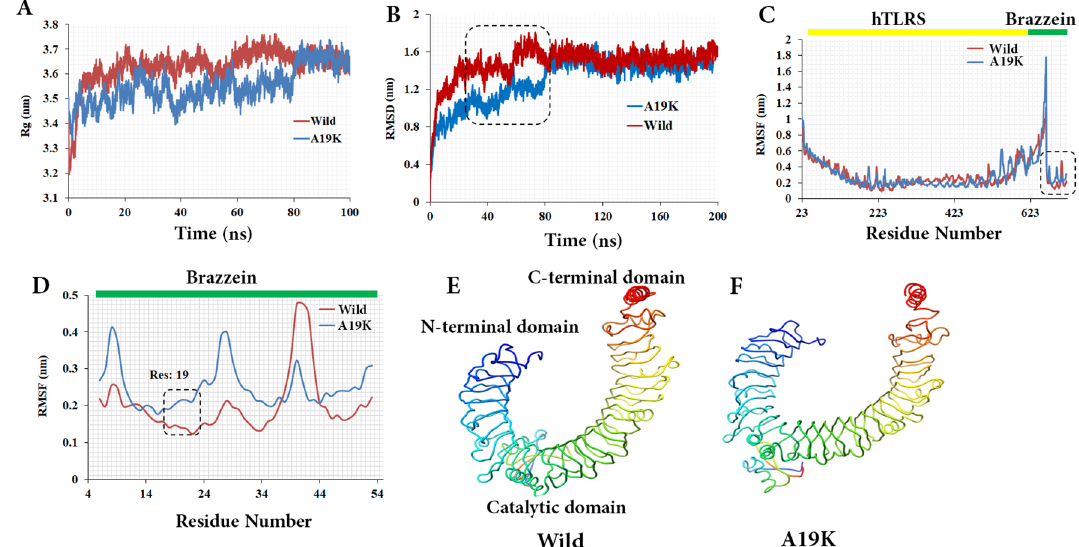
Figure 2. Intrinsic dynamic stability of the modeled hTLR5- WT and hTLR5-p.A19K complex during all- atoms MD simulation of 100 ns. ( A ) Radius of gyration (Rg) plot showing the compactness of trajectory of the two systems over the time scale of 100 ns. ( B ) The backbone RMSD of two MD systems over the time scale of 100 ns (blue: p.A19K-hTLR5 and red: hTLR5-WT complex). Square dashed line is the greatest flexibility in the WT. Bar plot showing the average RMSD for the WT and hotspot mutant forms. ( C ) The residual flexibility is measured by RMSF of Cα-atoms of the hTLR5-Brazzein. Square dashed line shows that the stability of CT end region for WT/hTLR5 was slightly more than p.A19K/hTLR5 complex. ( D ) The RMSF plot of Brazzein during the simulation time containing hotspot mutation. ( E , F ) B-factor analysis of the MD simulated WT and p.A19K/ hTLR5 complex,